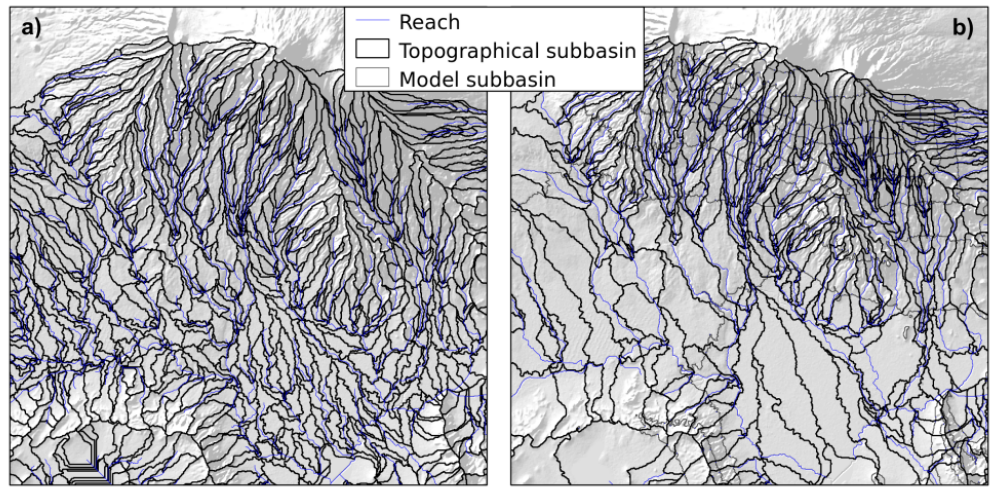
Fig. 3. Comparison of subbasins delineated with a conventional delineation tool (a) and with the script described in Sect. 3.4 (b) , on Mt. Kilimanjaro and its footzone. Model subbasins and topographical subbasins are identical in the conventional method.